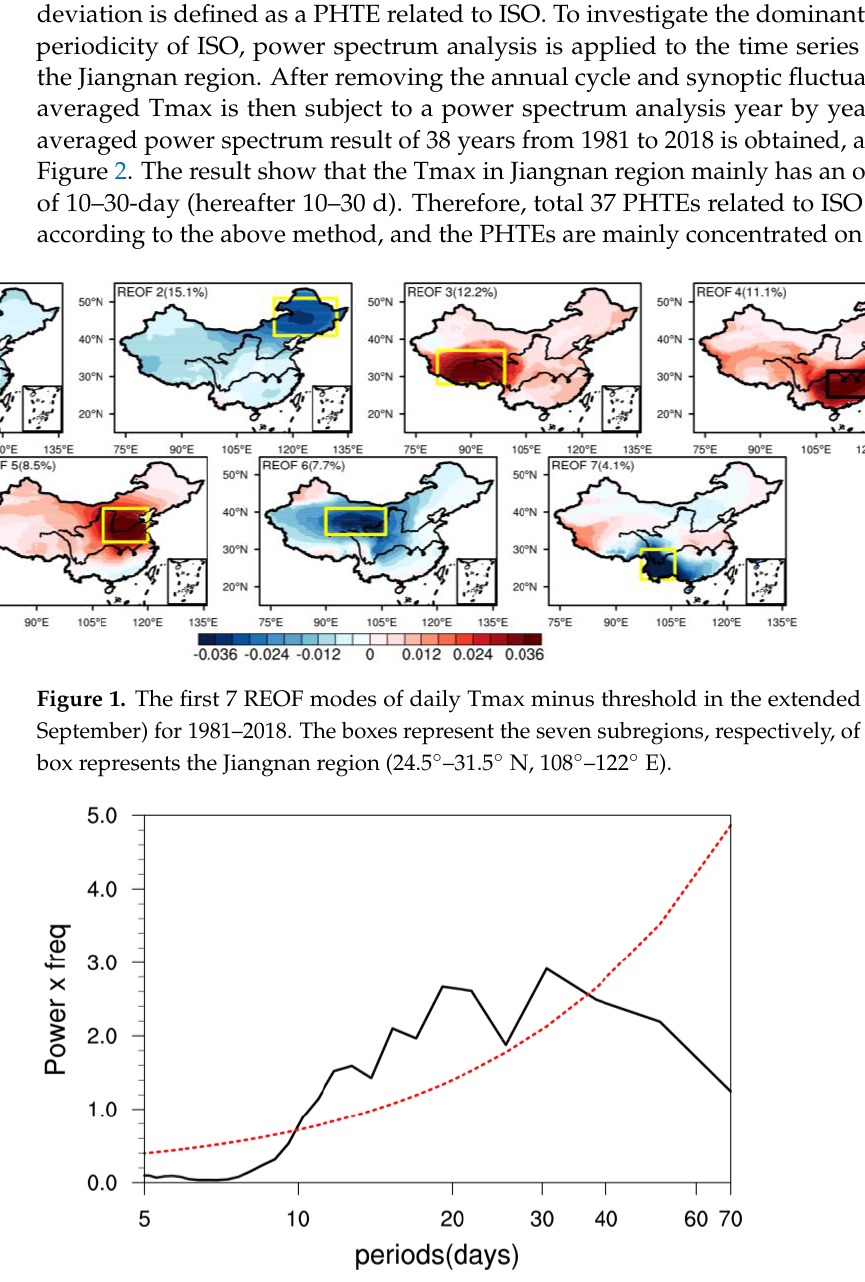
Figure 1. The first 7 REOF modes of daily Tmax minus threshold in the extended summer (May –